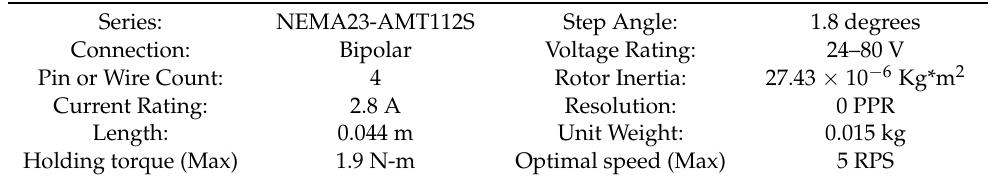
Table 2. NEMA23-AMT112S stepper motor features [30].